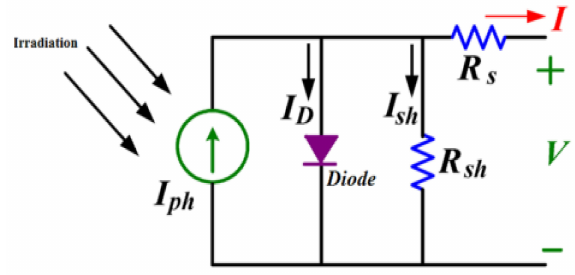
Figure 2. Solar PV equivalent circuit